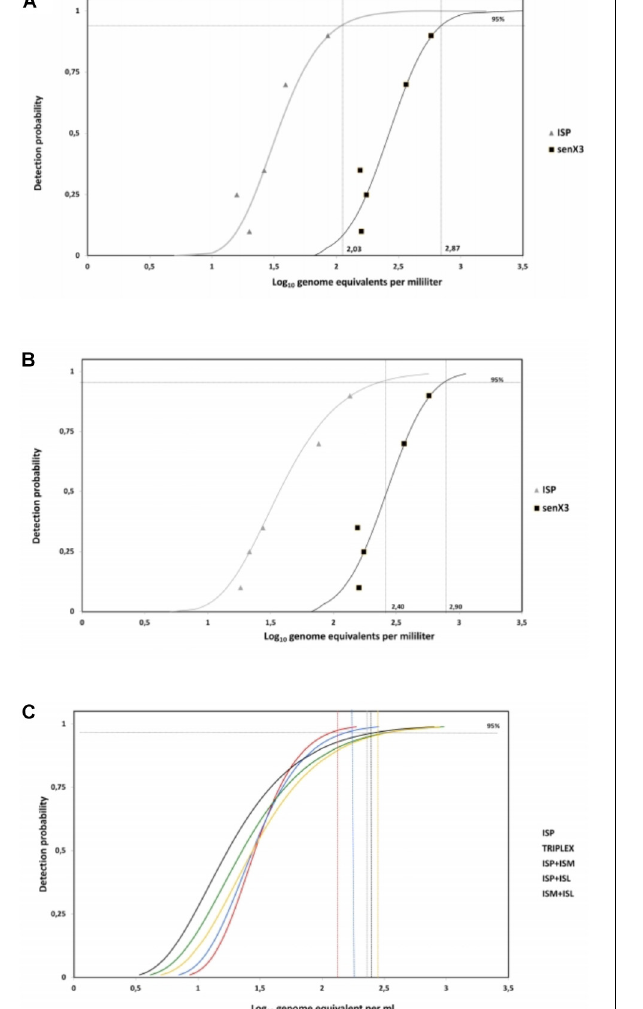
TABLE 2 | Intra run and inter run